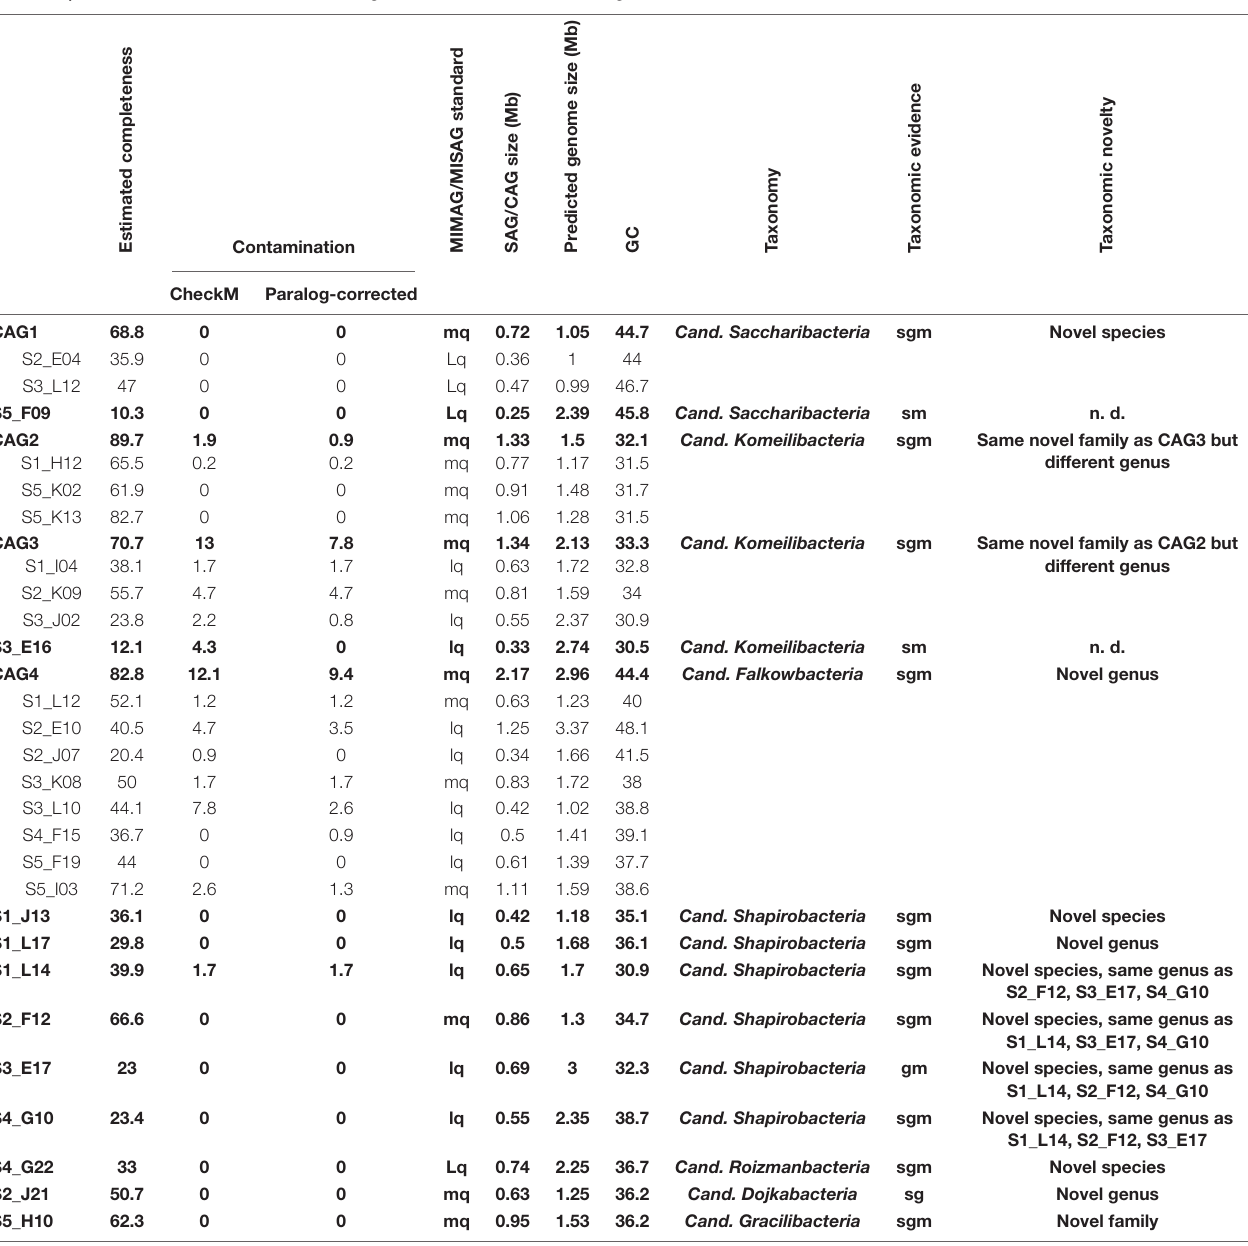
TABLE 1 | Patescibacteria/CPR SAGs and CAGs generated from successful sorting